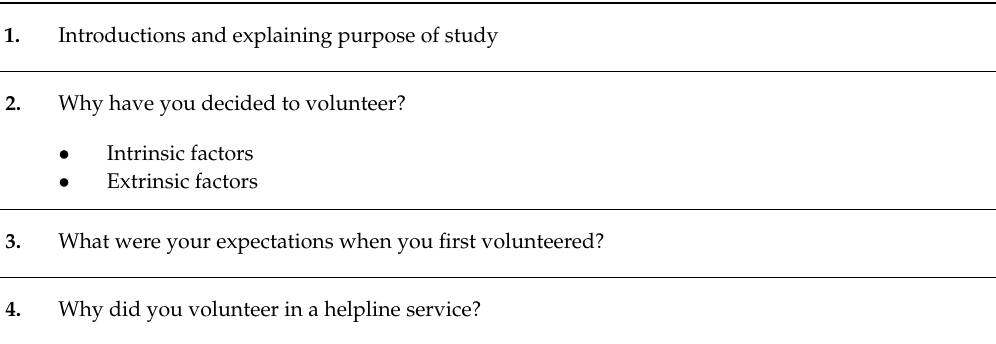
Table A1. Focus group and individual interview questions and